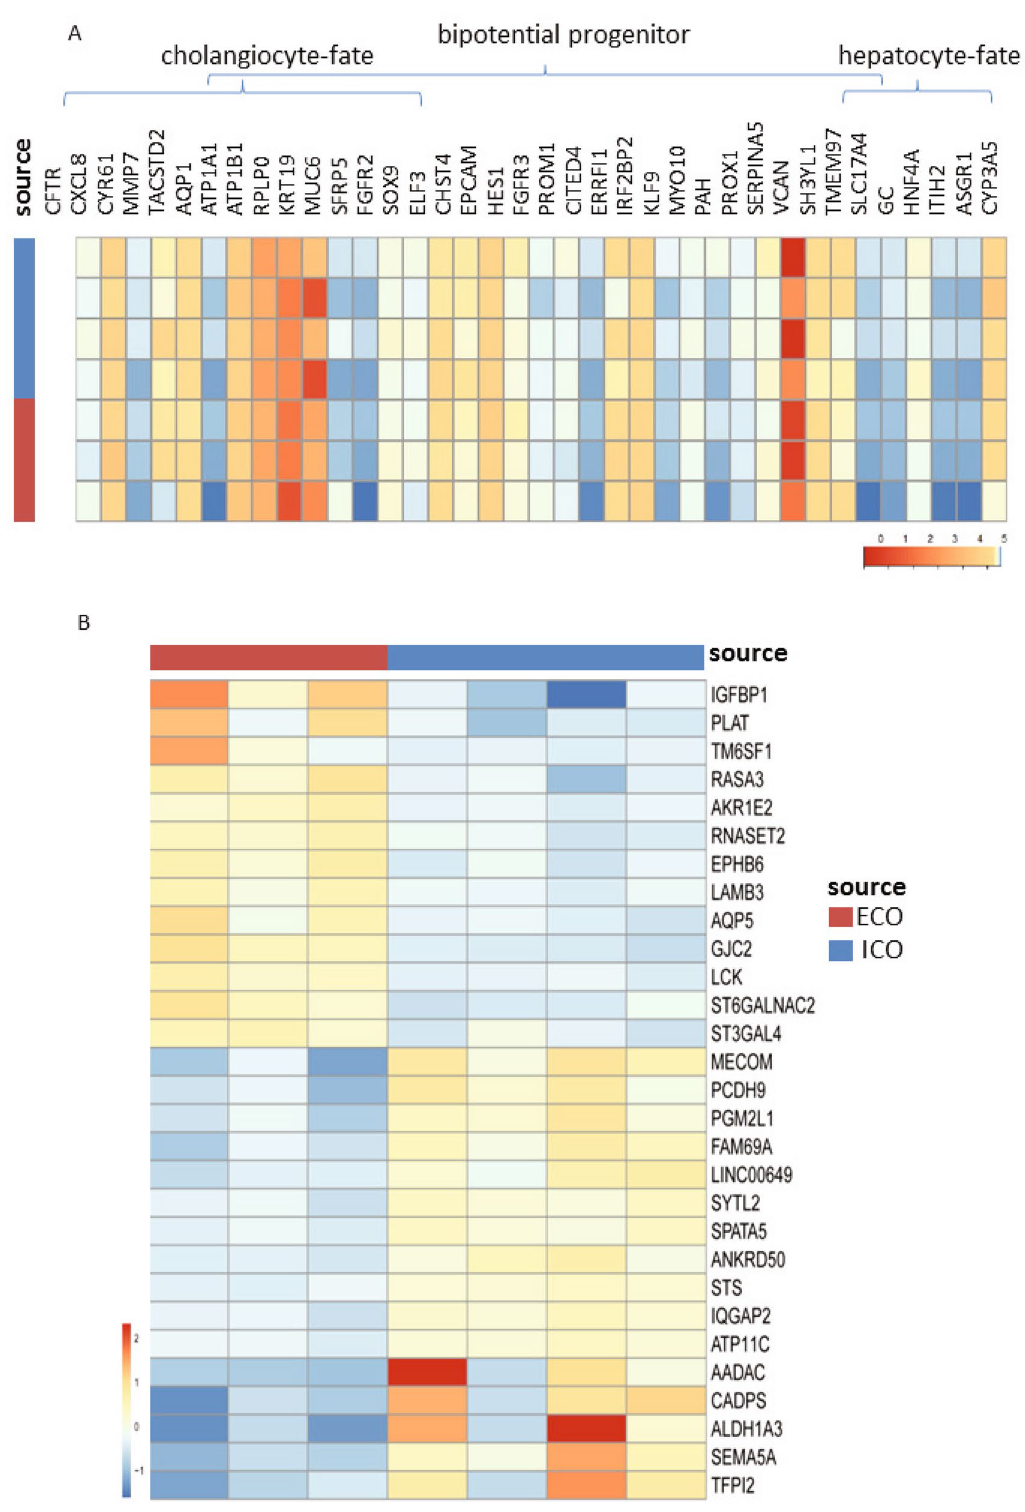
Figure 2. Limited differences in gene expression between ECO and ICO. Gene expression analysis of three paired ICO and ECO and one additional ICO line was performed using RNAseq. Selected genes, as described by Aizarani et al. 15 that are expressed in EpCAM-positive cells and associated with progenitors, hepatocyte-fate or cholangiocyte-fate. Shown are normalized (bulk) RNA sequencing results of the undifferentiated ECO and ICO for this specific gene set. Expression of the progenitor, hepatocyte-fate- and cholangiocyte-fate associated genes was similar between ECO and ICO. The expression heatmap shows Z-scores that are color-coded as shown ( A ). No significant differences between ICO and ECO for this gene set was observed. The expression heatmap ( B ) indicates clusters of genes that are differentially expressed (29 in total, p adjusted < 0.05), 13 higher expressed in ECO and 16 higher in ICO. This analysis reveals that although both organoid types are very similar in gene expression profiles, there are some differences albeit in a relatively low number of